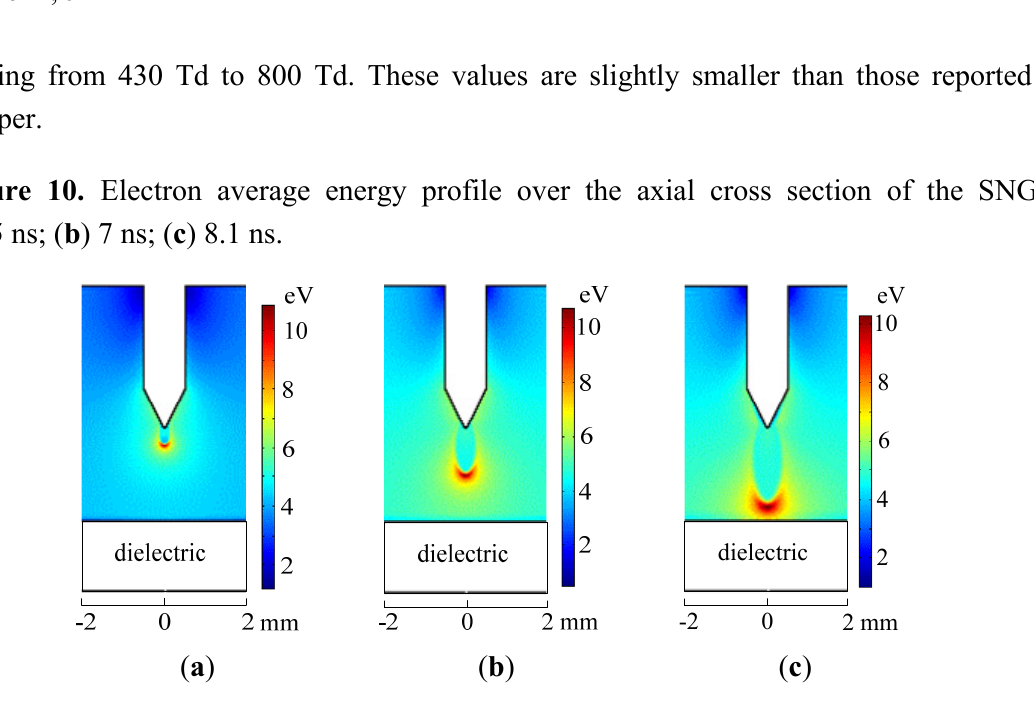
Figure 11. Electron average energy along the axis of symmetry for the SNG.